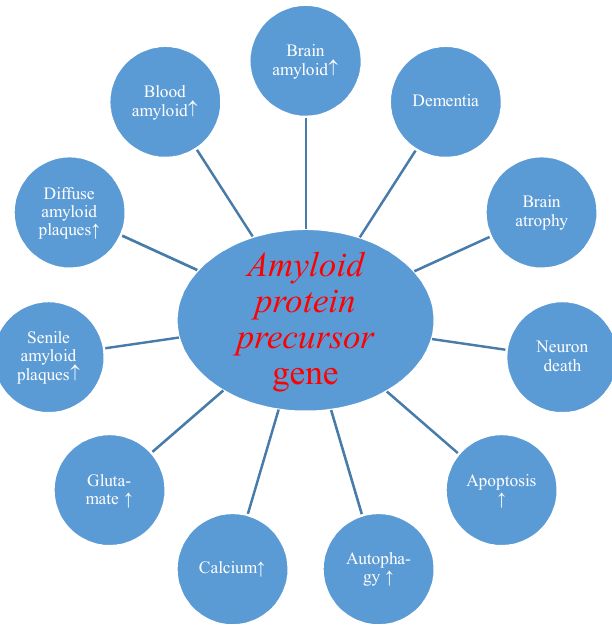
Figure 1. Potential role of amyloid protein precursor gene changes during brain injury due to ischemia-reperfusion. ↑ -increase.